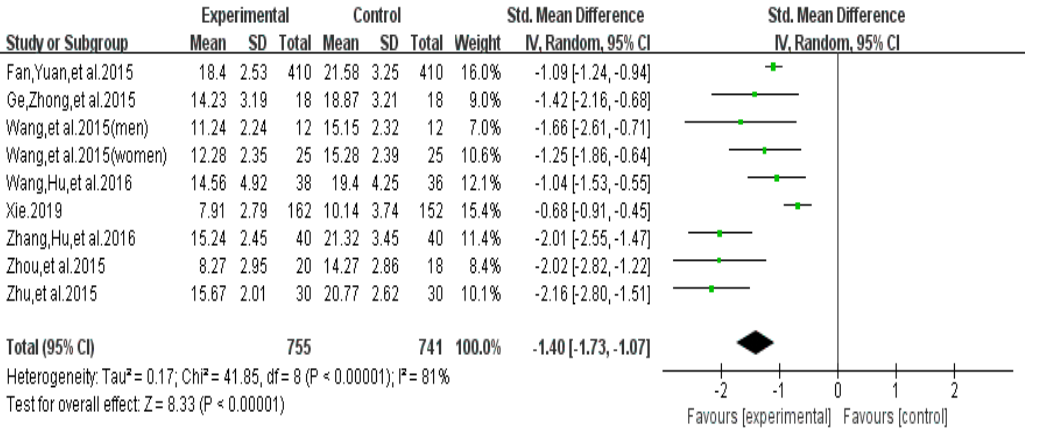
Figure 5. Effect of exercises on withdrawal symptoms.